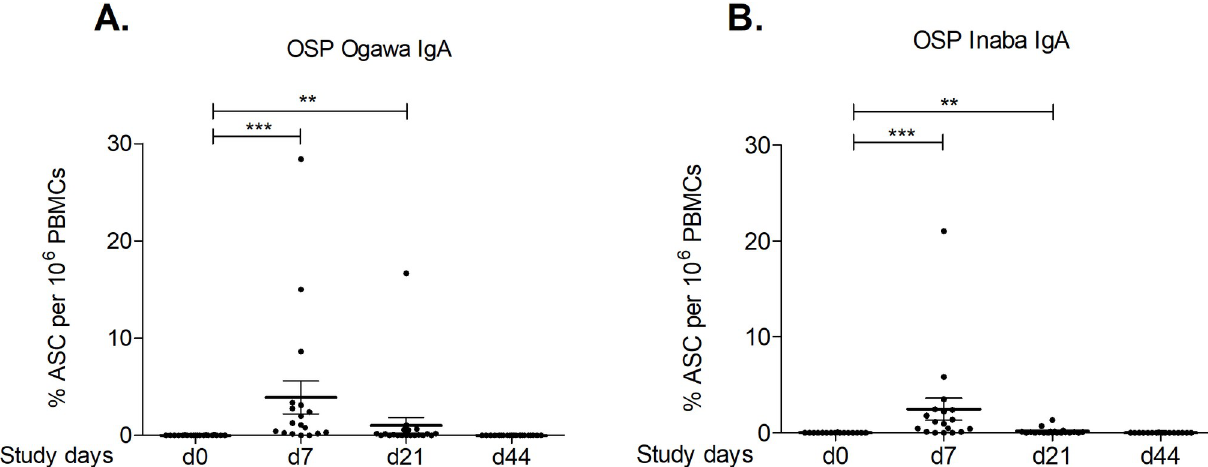
Fig 3. Ogawa and Inaba O-specific polysaccharide (OSP) IgA antibody secreting cell (ASC) responses in vaccine recipients. Mean ± standard errors of the mean (SEM) of the fraction of circulating IgA ASC responses specific for Ogawa (A) and Inaba (B) OSP, out of total circulating IgA ASC responses on the same day. The Wilcoxon signed-rank test was used for analyses of the data. Asterisks denote statistically significant differences from baseline (day 0) ( ��� = P = 0.0005, �� = P < 0.01).